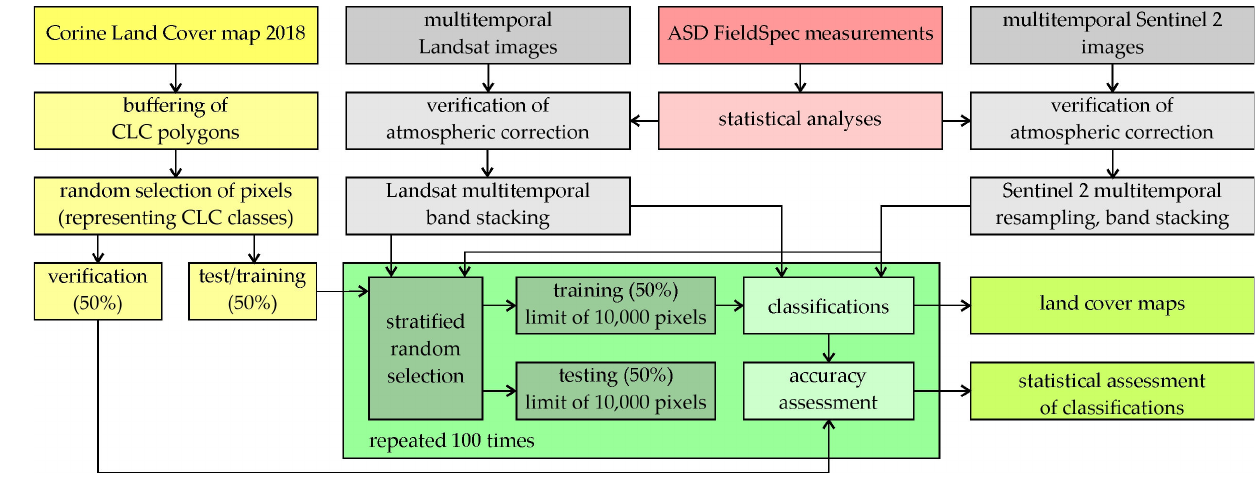
Figure 4. Method schematic.